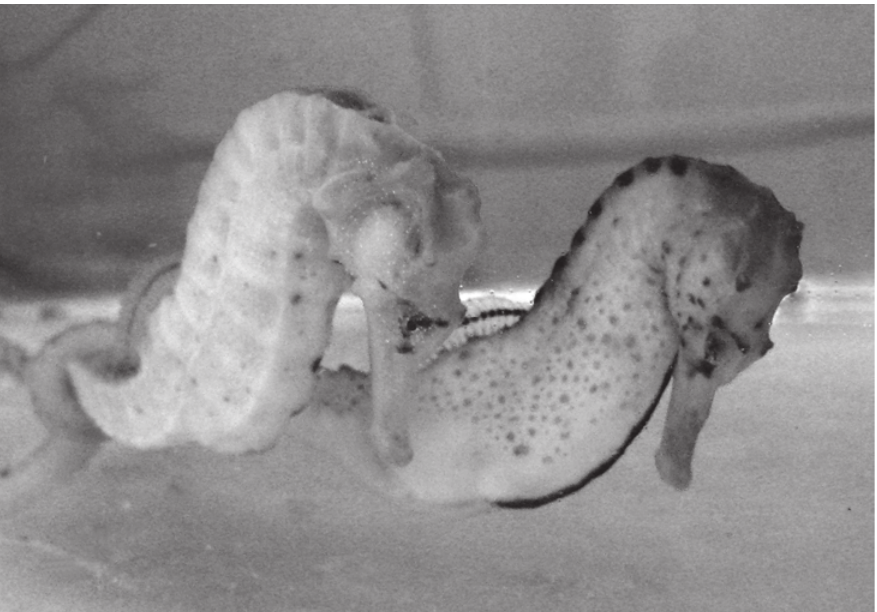
Fig. 4. A captive-reared pair of Hippocampus reidi with the male (right) showing highlighted dorsolateral spots and keel, during courtship. Photo credits: T. P. R.